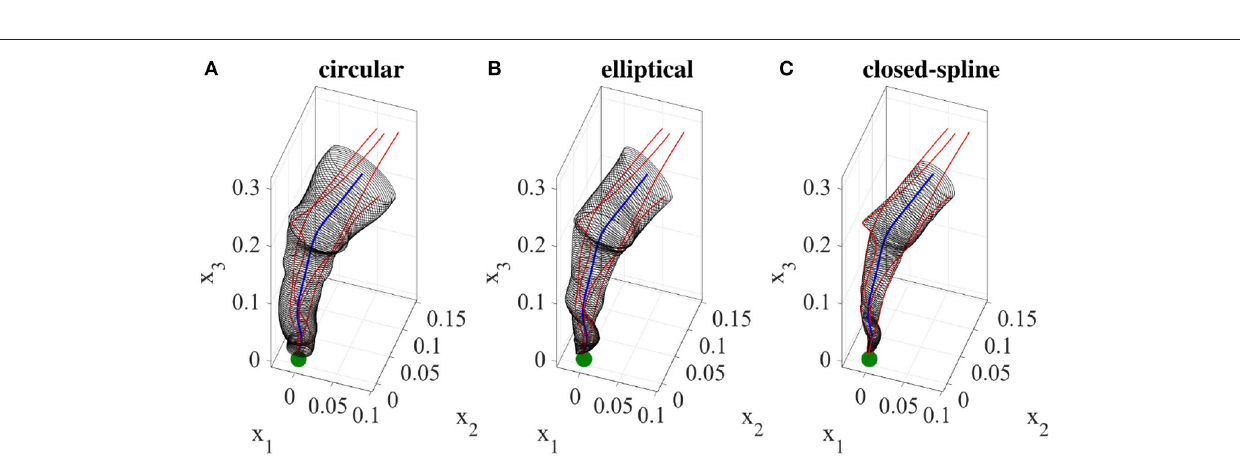
FIGURE 5 | A reaching skill encoded using three generalized cylinders with different cross-section types. The demonstrations and the object are shown in red and green respectively.